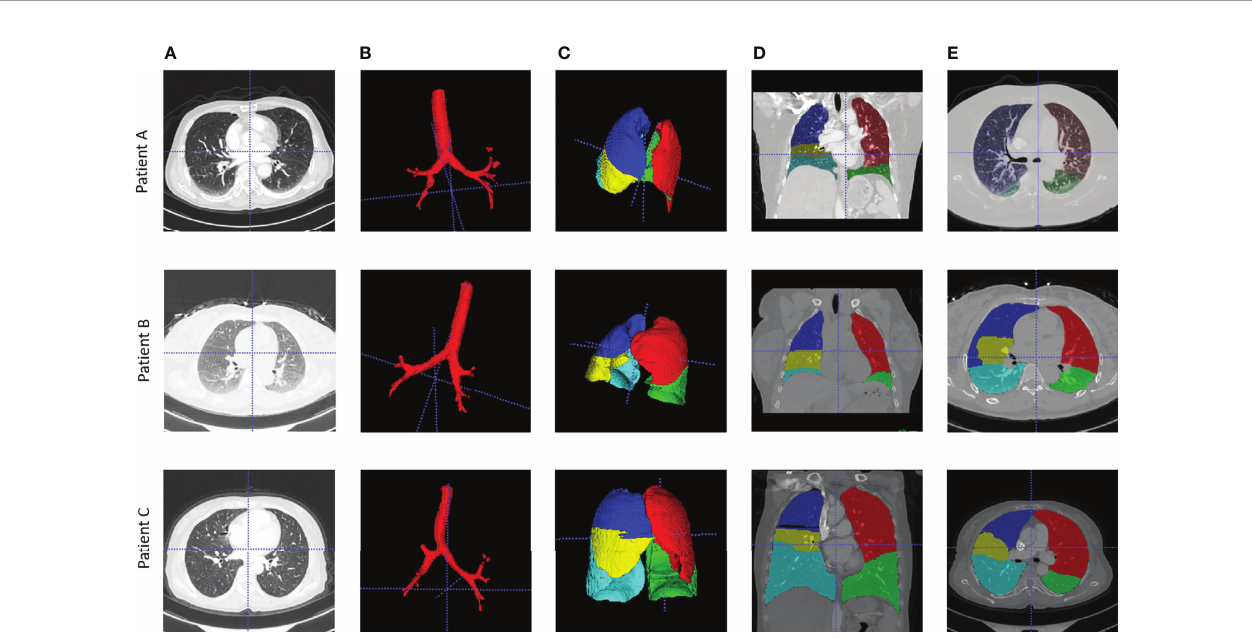
FIGURE 1 | Examples of airway and lung lobes segmentation. (A) Patient raw CT scan; (B) Airway segments produced by region-growing algorithm; (C) lung lobes segments, 3D; (D) Lung lobes segments, x-axial 2D; (E) Lung lobes segments, z-axial